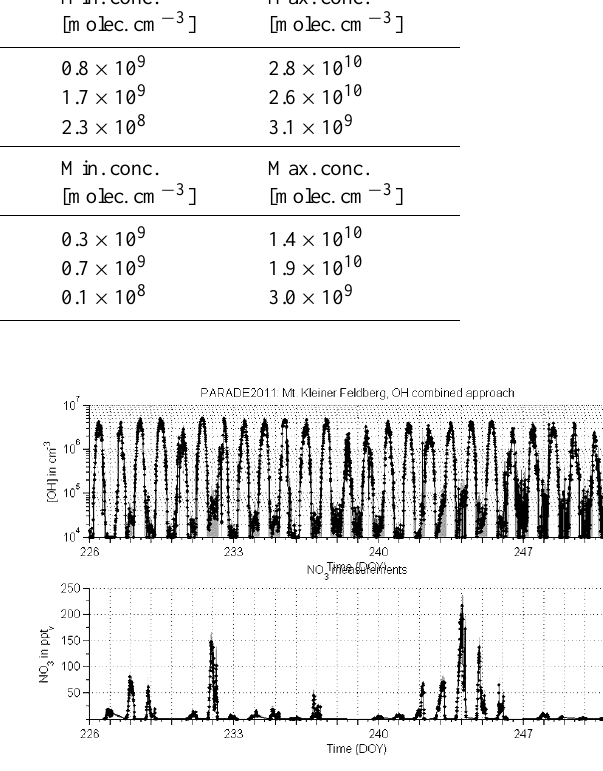
Figure 7. Detailed behaviour of detected ambient ozone and 10-fold increased NO mixing ratios. The detection limit of NO was 21ppt v . mixing ratios were 460 ppt v and night-time ones in the order of 20 ppt v . Note that the detection limit for NO was 21 ppt v .